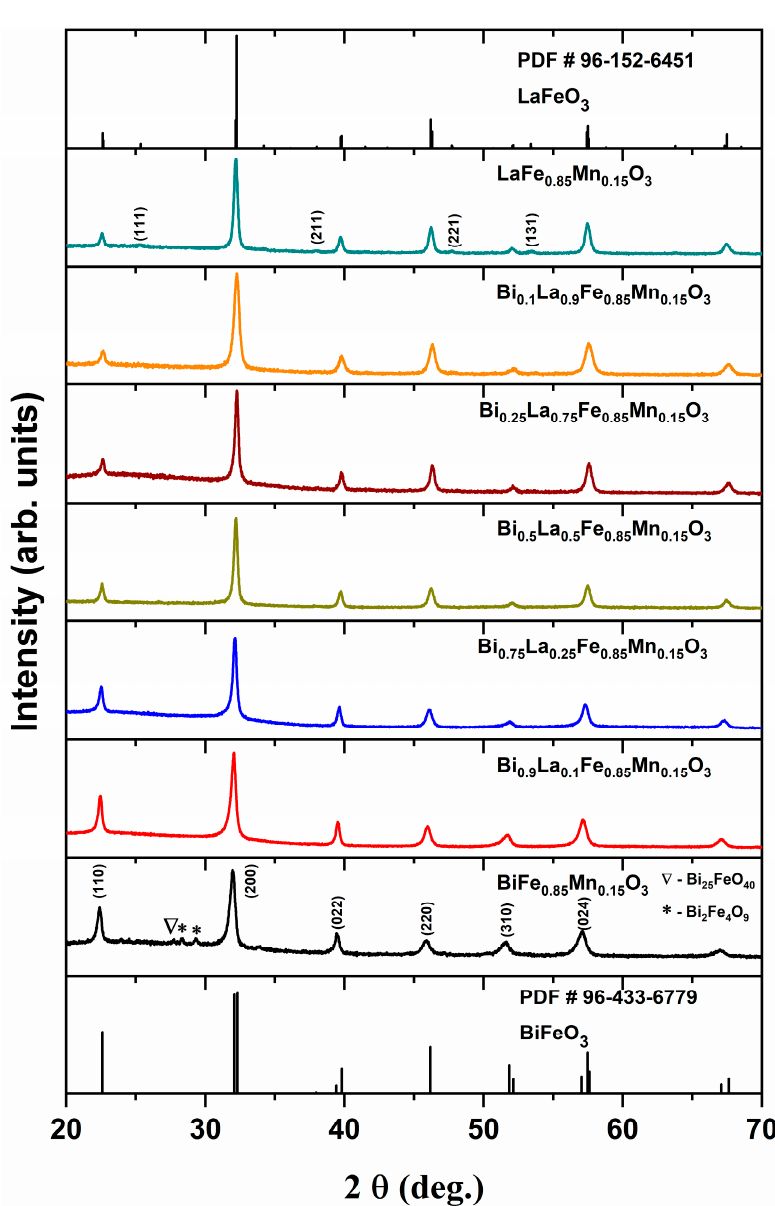
Figure 2. XRD patterns of Bi 1-x La x Fe 0.85 Mn 0.15 O 3 samples.